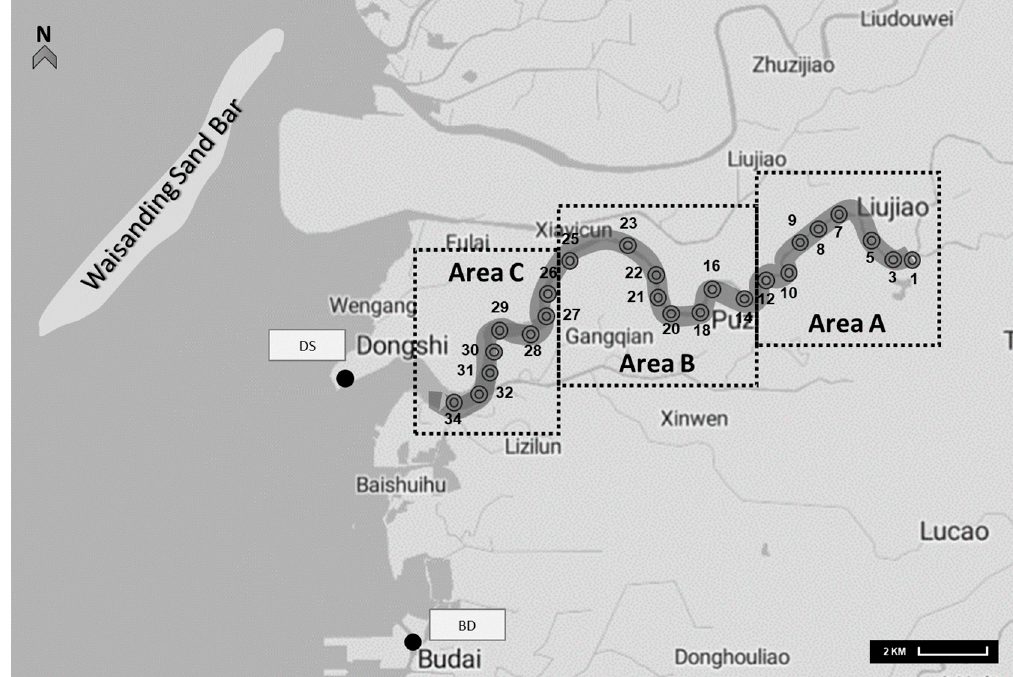
Figure 2. The illustration of the sampling sites and the Puzih River tributaries. The Puzih River is located in a subtropical area under the influence of high population density and significant numbers of aquaculture. The sampling sites of surface water in PR ( ◎ ) and fishing harbors ( ● ) are marked accordingly.